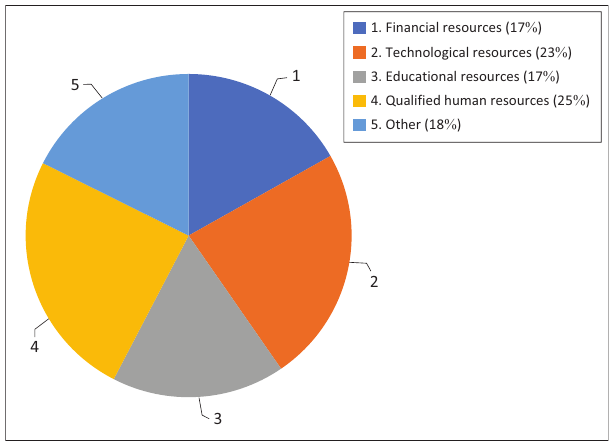
FIGURE 8: Resource gaps for African leaders.